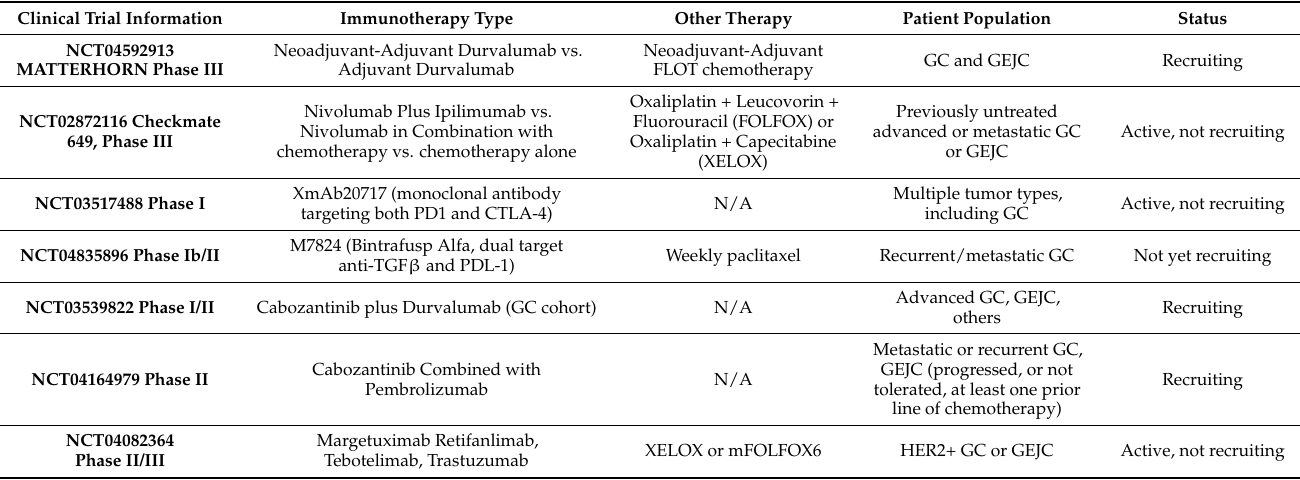
Table 1. Select Ongoing Trials Involving Immune Checkpoint Inhibitors for